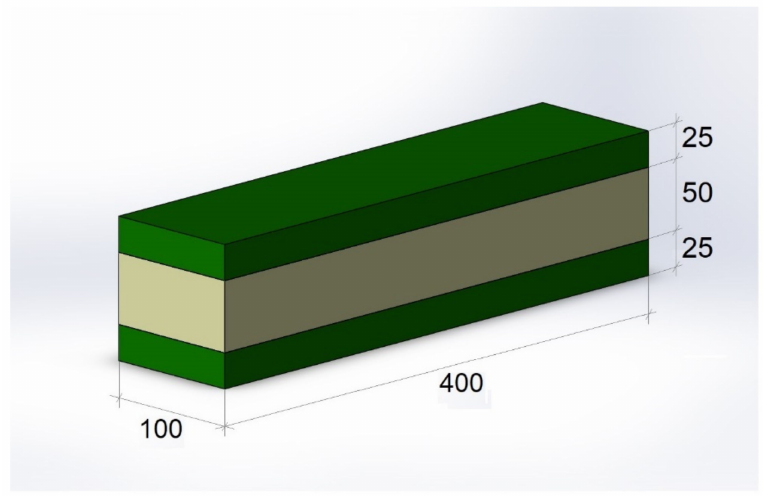
Figure 5. Fiber distribution in the prism of Group A2. Group